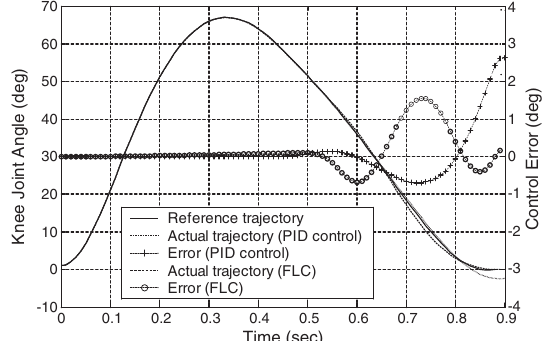
Fig. 13. Reference and actual trajectory and tracking error with PID and FL control scheme-I.